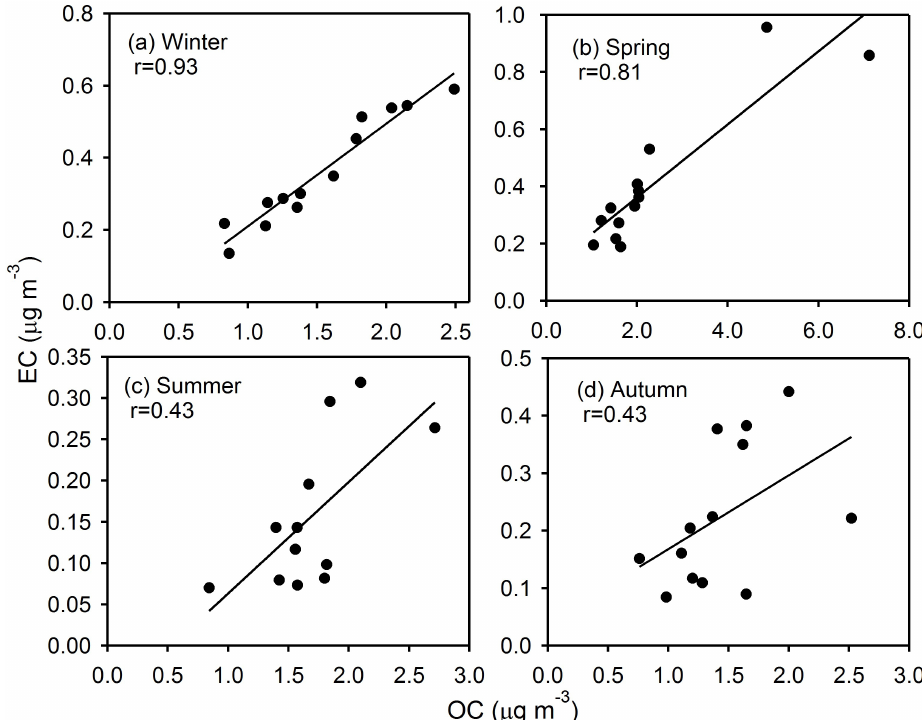
Fig. 6. Correlation analysis between elemental carbon (EC) and organic carbon (OC) in ambient aerosol samples collected from Cape Hedo Okinawa.